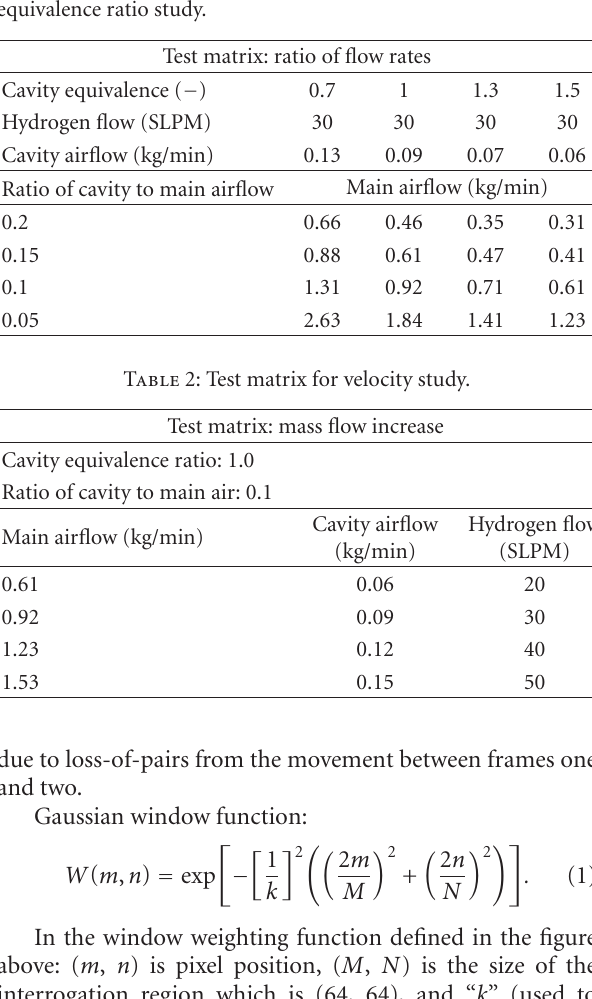
Table 1: Test matrix for cavity to main channel flow rate ratio and equivalence ratio study.